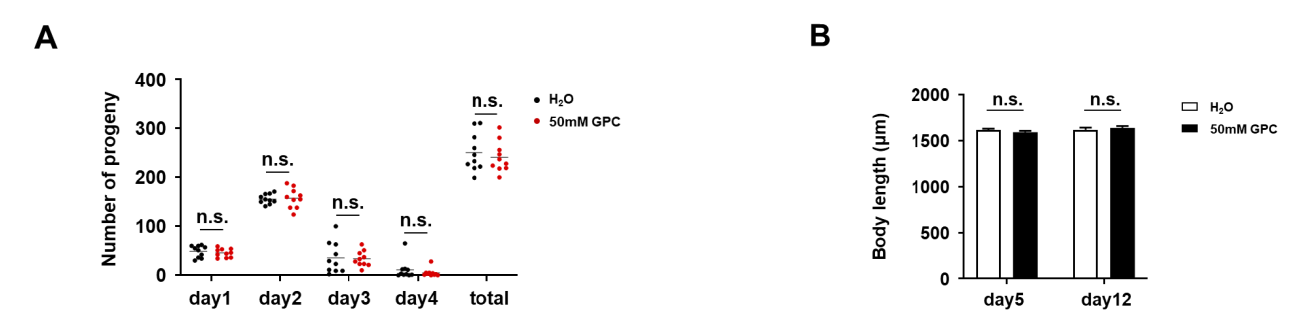
Figure 4. GPC has no adverse effect on the fecundity and body length of C. elegans . ( A ) The number of progenies on days 1, 2, 3 and 4 was scored, and the total number of progenies was summarized. ( B ) The body length of nematodes on days 5 and 12 was measured. n.s., not significant; by two-way analysis of variance (ANOVA) followed by Bonferroni tests. Values are mean ± s.e.m.